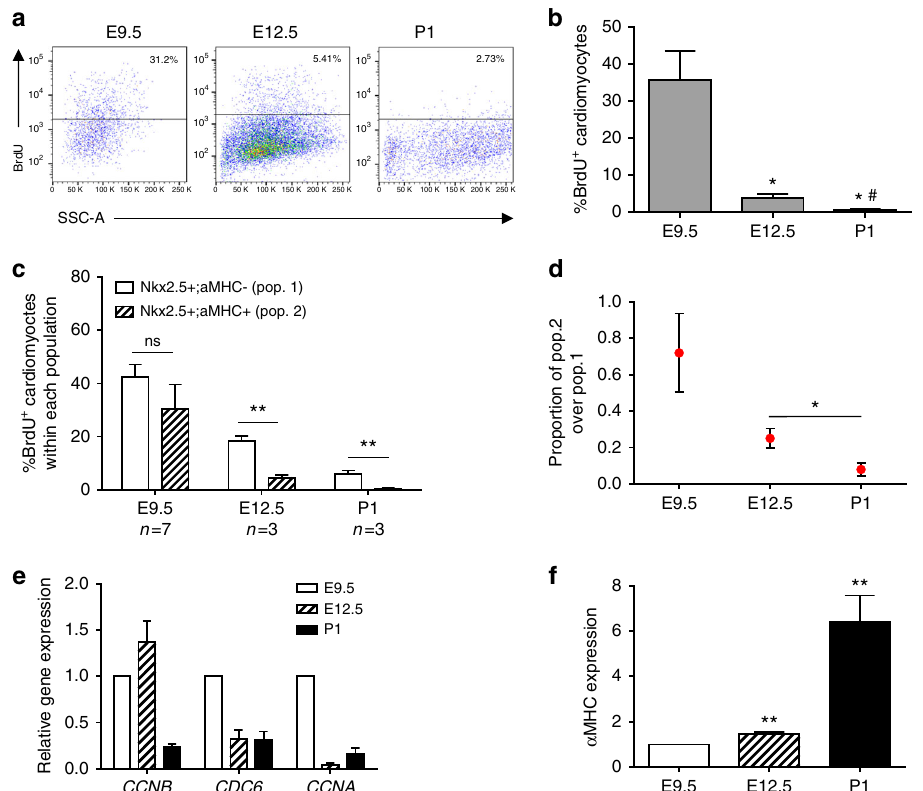
Fig. 4 BrdU pulse-chase experiments substantiate decreasing proliferative capacity of CMs. a Representative fl ow cytometric analysis of BrdU incorporation. BrdU was given at E9.5, E12.5, or P1 α MHC-GFP mice 3 h prior to analysis. b Quanti fi cation of BrdU + α MHC-GFP + cells at E9.5, E12.5, and P1. (Student ’ s t test), *E12.5 or P1 vs. E9.5, # P1 vs. E12.5, p < 0.05. c Quanti fi cation of percent BrdU incorporation in Nkx2.5 + ; α MHC − and Nkx2.5 + ; α MHC + cells at E9.5, E12.5, and P1. (Student ’ s t test), ** p < 0.01. d Proportion of BrdU + cells within the cardiomyocyte (Nkx2.5 + / α MHC + ) compared to progenitor (Nkx2.5 + / α MHC − ) populations at E9.5, E12.5, and P1. (Student ’ s t test), * p < 0.05. e qPCR analysis of α MHC-GFP+ cells reveals an age-dependent drop in expression of cell cycle genes ( Ccna2 , Ccnb1 , Cdc6 ). f qPCR analysis of α MHC gene expression in α MHC-GFP+ cells from E9.5 to P1. All measurements shown are depicted as mean ±